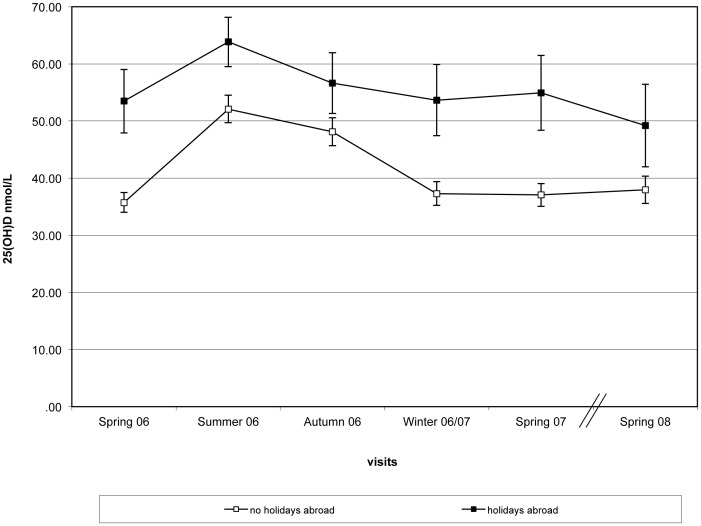
Differences in 25(OH)D between women who have had holidays abroad the preceding 3 mo from their study visits [N = 74 (spring 2006), 104 (summer 2006), 96 (autumn 2006), 52 (winter 2006/07), 58 (spring 2007), 40 (spring 2008] and those who did not (N = 289, 234, 231, 262, 251, 218, respectively).(all differences where statistically significant at p<0.001.) 25-hydroxyvitamin D (25(OH)D) (bars represent mean ± SEM) according to season/visit.